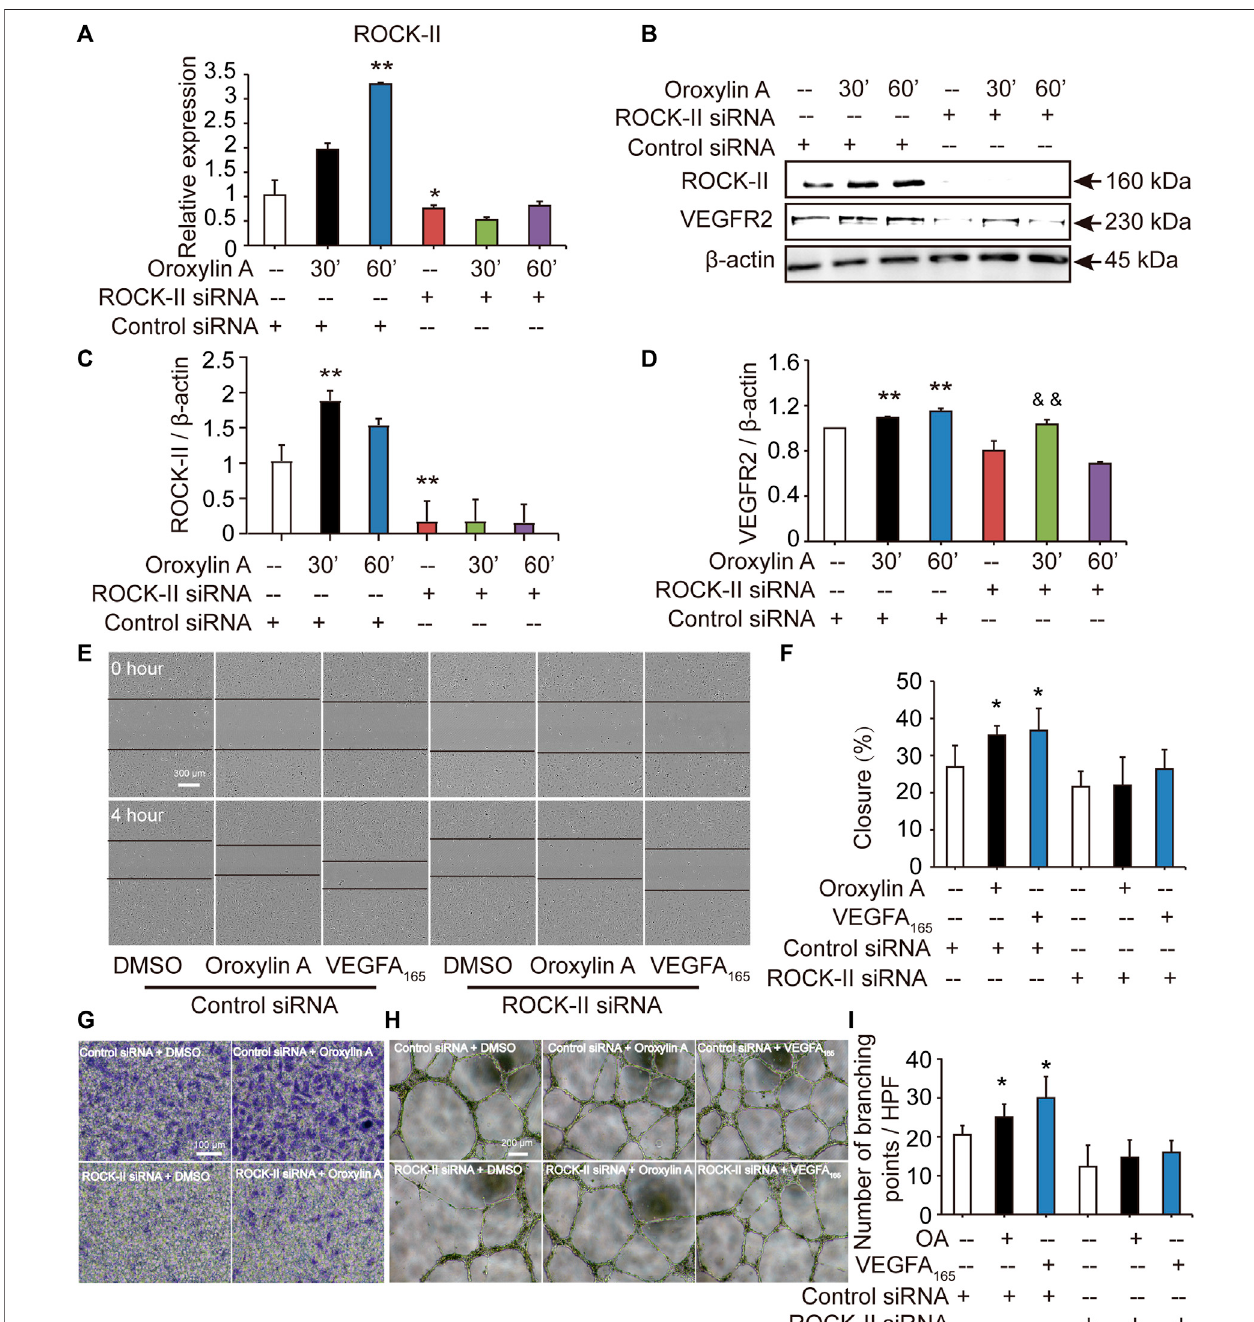
FIGURE 5 | Cell migrations and capillary-like structures of HUVECs induced by OA were decreased by silencing ROCK-II with siRNA. HUVECs were transfected withnon-speci fi csiRNAorROCK-IIsiRNAandstimulatedwithDMSOor2.5 μ MOAfor30,60 minandanalyzedusingqRT-PCR (A) .WesternblottinganalysisofROCK- II and VEGFR2 in HUVECs transfected with non-speci fi c siRNA or ROCK-II siRNA and stimulated with DMSO or 2.5 μ M OA for 30, 60 min were performed in (B) . Quantitative data included ROCK-II (C) and VEGFR2 (D) . The mobility of HUVECs was analyzed by using scrape injury, with VEGFA 165 as a positive control. HUVECs were transfected with control siRNA or ROCK-II siRNA and stimulated with DMSO, 2.5 μ M OA or VEGFA 165 for 4 h (E) . Quantitative data were shown in (F) . Performed Transwell invasion of HUVECs transfected with control siRNA or ROCK-II siRNA and stimulated with DMSO or 2.5 μ M OA were presented in (G) . Representative images of tube formation of HUVECs transfected with control siRNA or ROCK-II siRNA and stimulated with DMSO, 2.5 μ M OA or VEGFA 165 were presented, with VEGFA 165 as a positive control (H) . Quantitative data were shown in (I) . Data were represented as mean ± SD ( n (cid:2) 3). * p < 0.05; ** p < 0.01 vs . control siRNA, && p < 0.01 vs . ROCK-II siRNA.